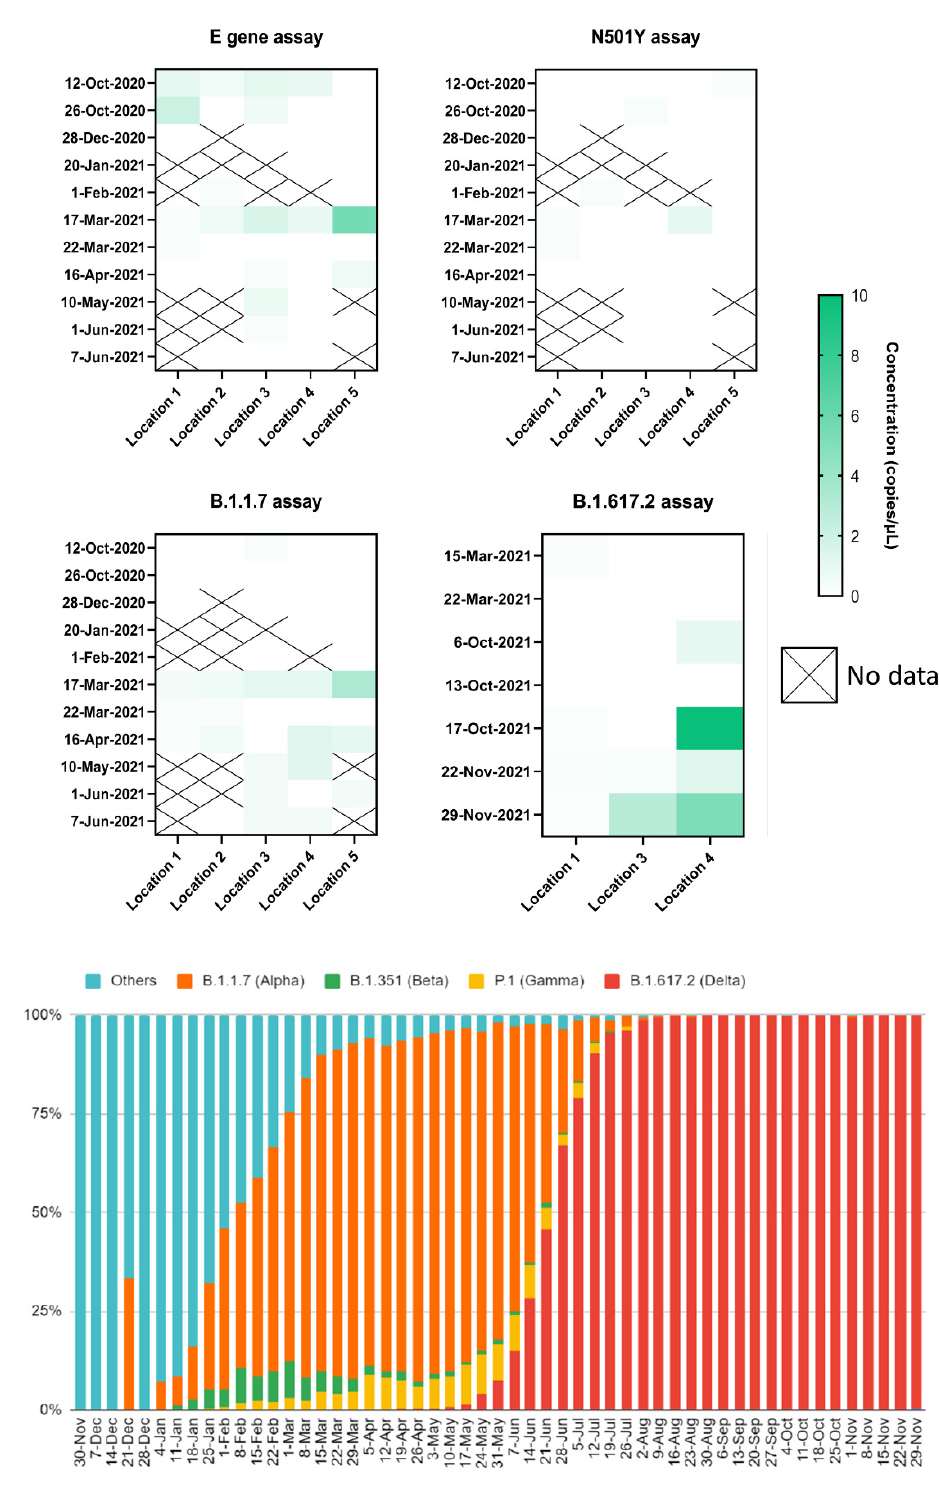
Figure 4. Application of the digital PCR assay to influent wastewater samples originating from 5 Belgian wastewater treatment plants. Information on the genomic surveillance of SARS-CoV-2 was adopted from [50]. No sample was analyzed for the dates with ‘X’ since these timepoints were negative during the national wastewater surveillance program. For the same reason, locations 2 and 5 were not included for the evaluation of the B.1.617.2 assay.